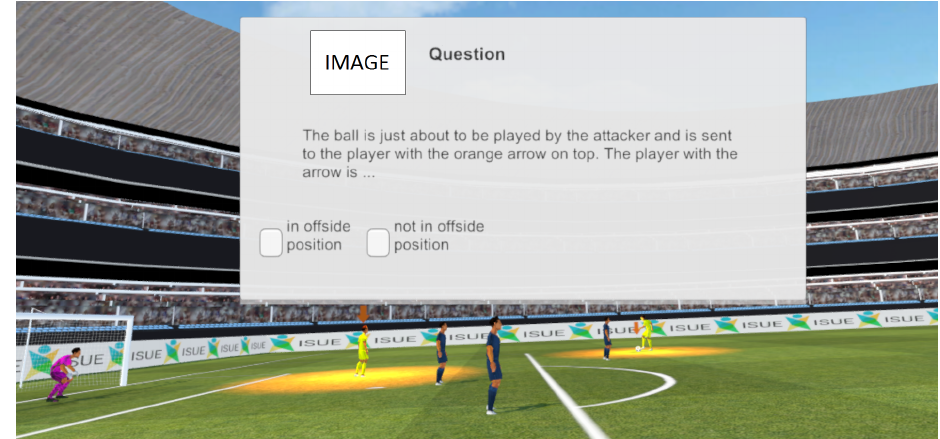
Figure 4. In this figure a question is presented to the user with 2 options to answer. The question belongs to the easy